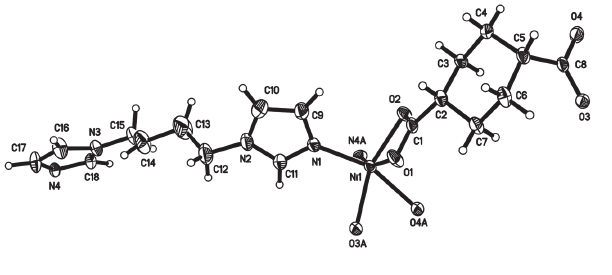
Table 1: Data collection and handling.